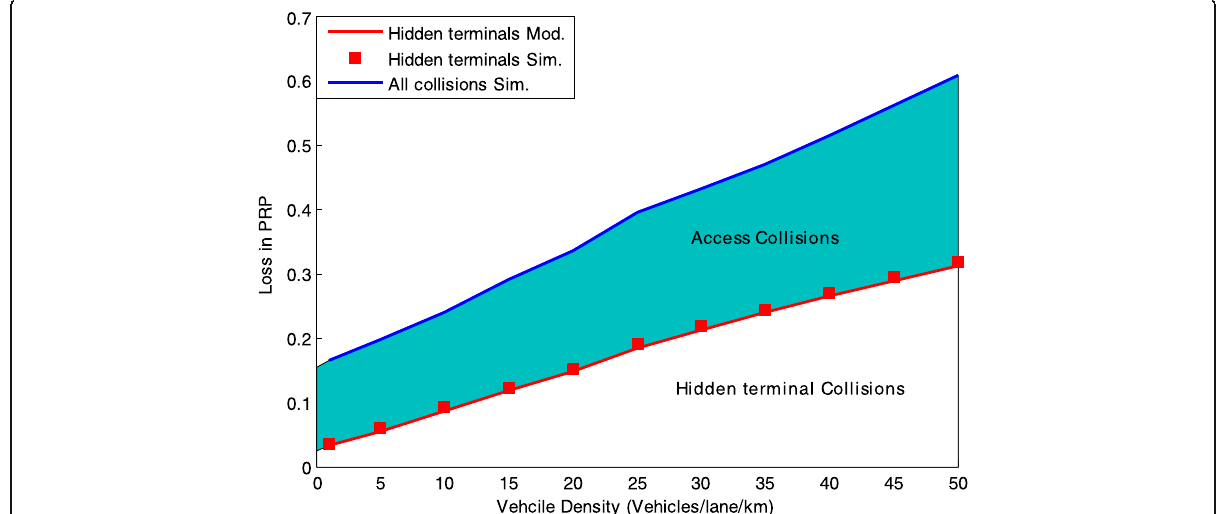
Fig. 9 Loss in the PRP due to hidden terminal collisions for the analytical model (Mod.) and simulations (Sim.) and all type of collisions for simulation. The network parameters are W